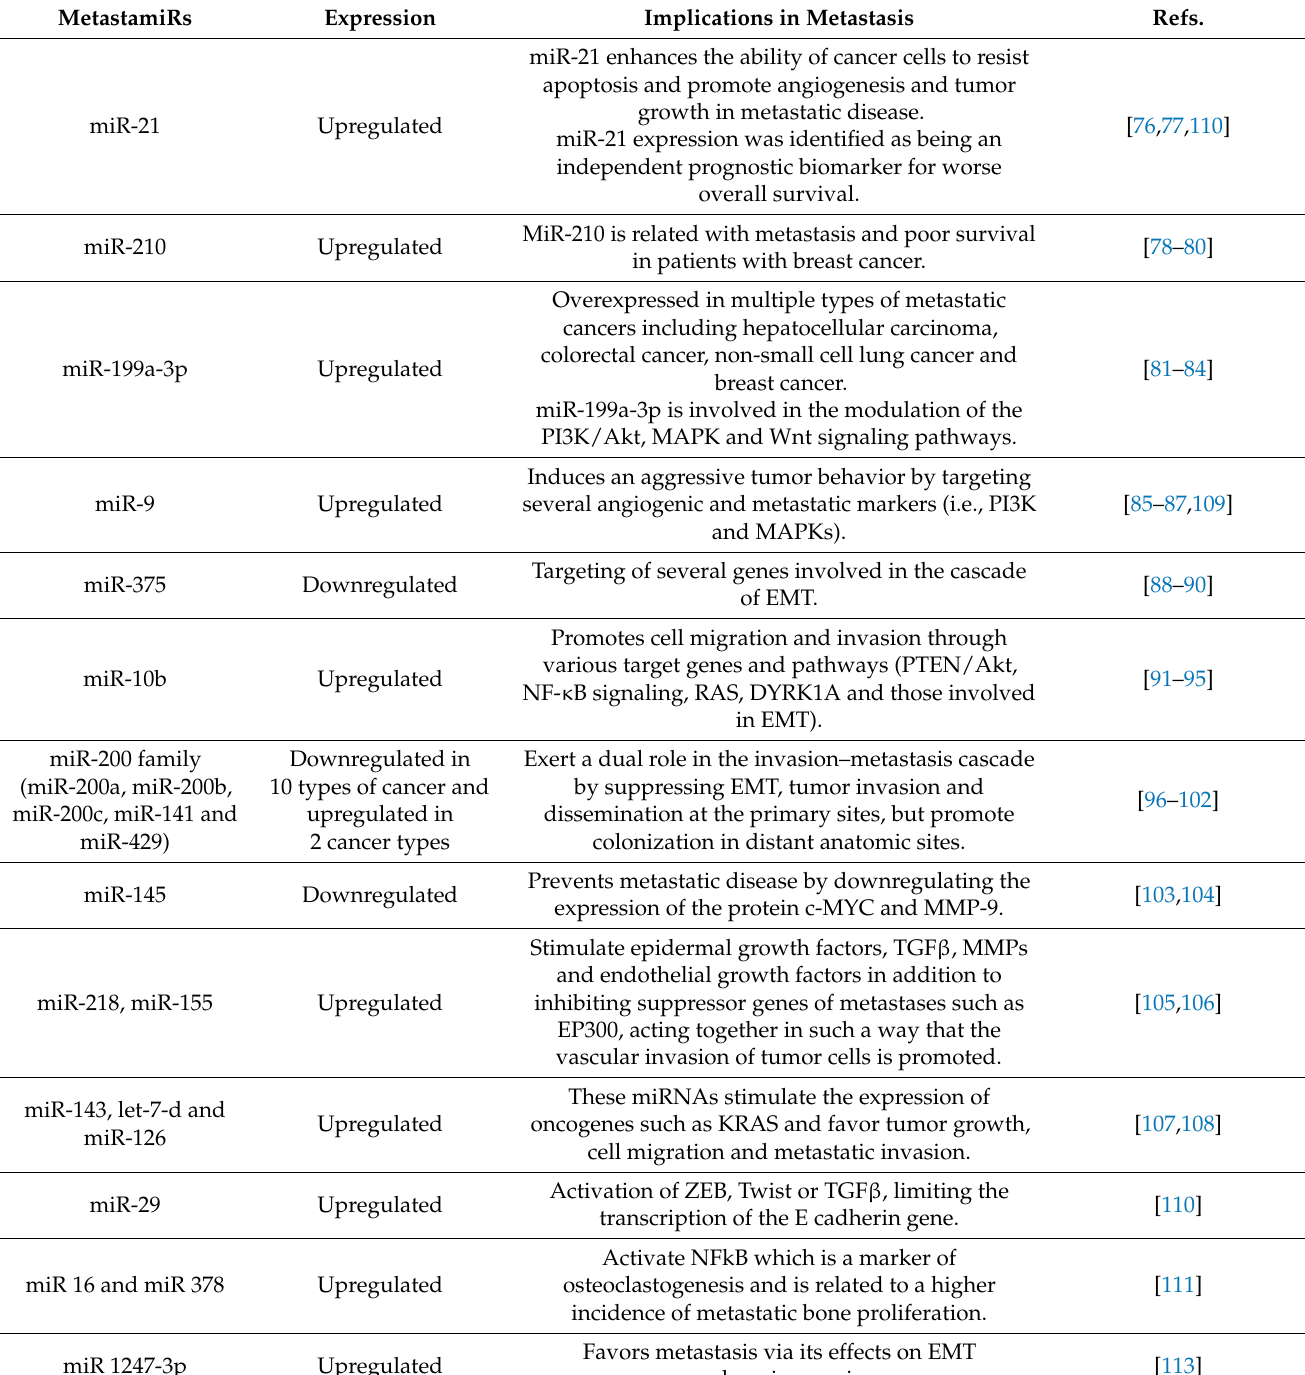
Table 3. MetastamiRs and their expression and role in